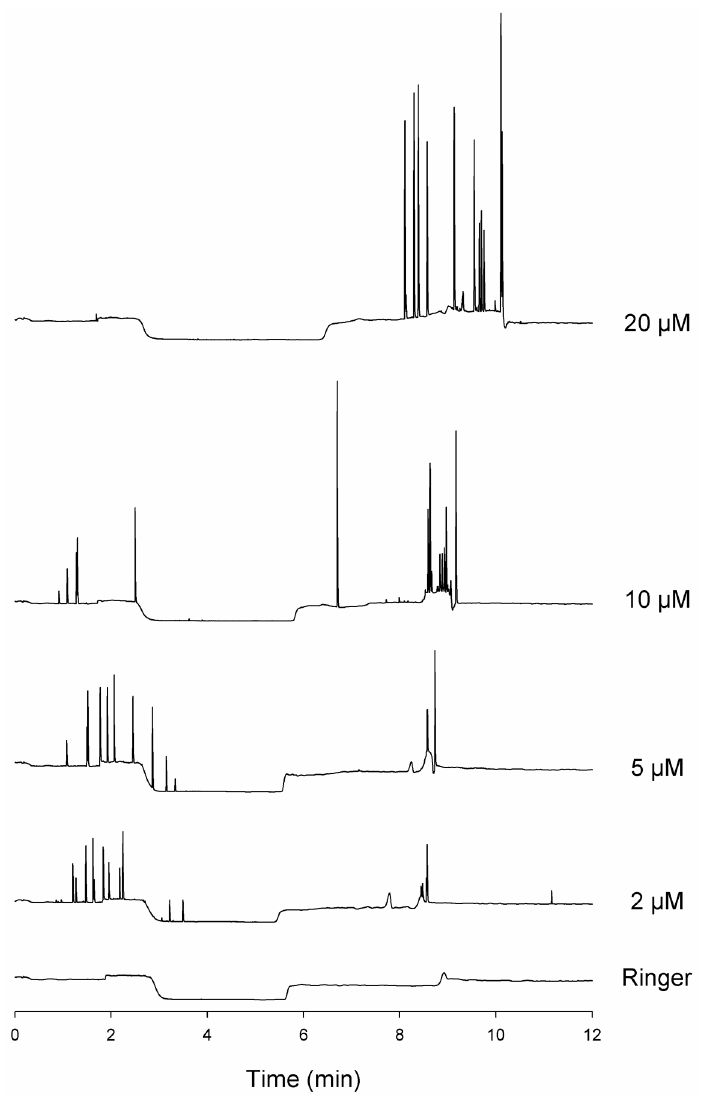
Figure 6. Capillary electrophoresis separation of 18-day incubated 2, 5, 10 or 20 µM A β 1-40. Effect of A β 1-40 concentration during an 18-day incubation on the capillary electrophoresis separation. The concentration of sample was 2, 5, 10 and 20 µM. The analysis of a control incubated Ringer is also included. Running buffer as in Figure 1. Injection 2 psi/80 s.